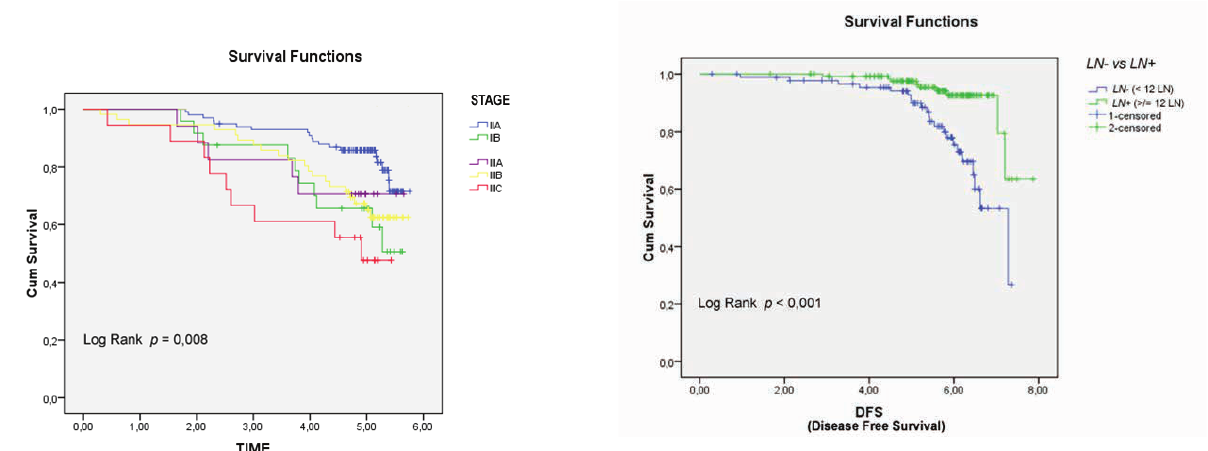
Figure 5: Disease-free survival (DFS) in colorectal cancer patients with lymph node negative (LNs-) and lymph node positive (LNs+) (relapse rate 6.6% vs 21.15%, respectively; p < 0.001).